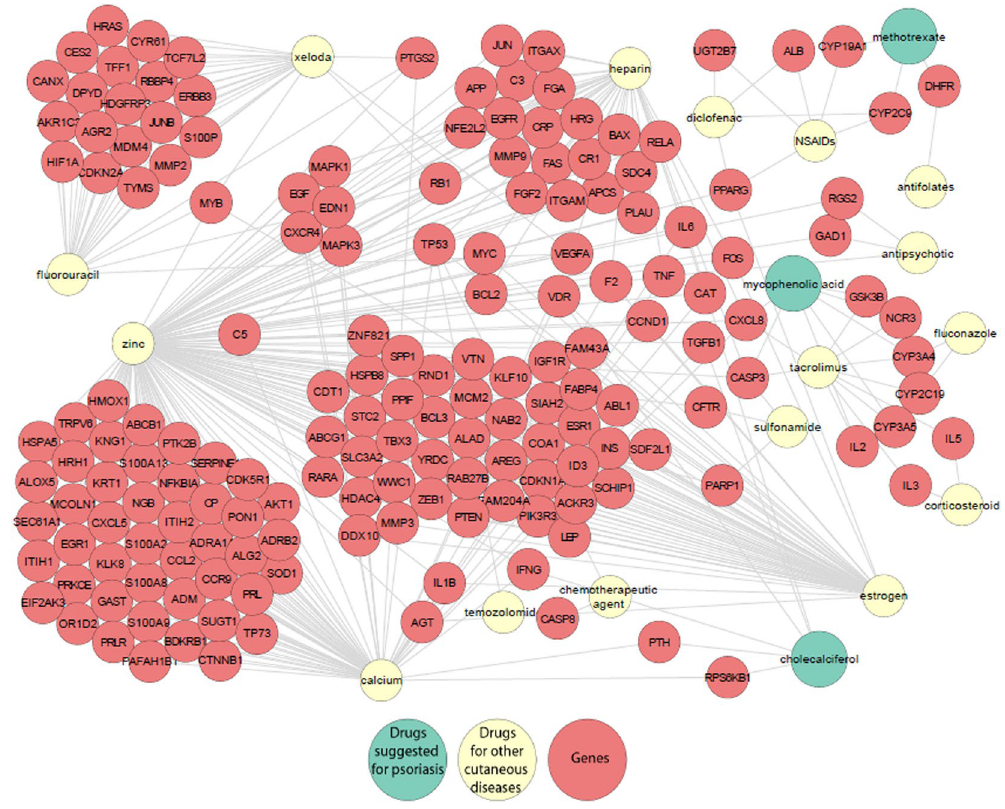
Figure 4. Gene - DDI network for cutaneous diseases showing interaction between NDFRT drugs suggested for cutaneous diseases/drugs with